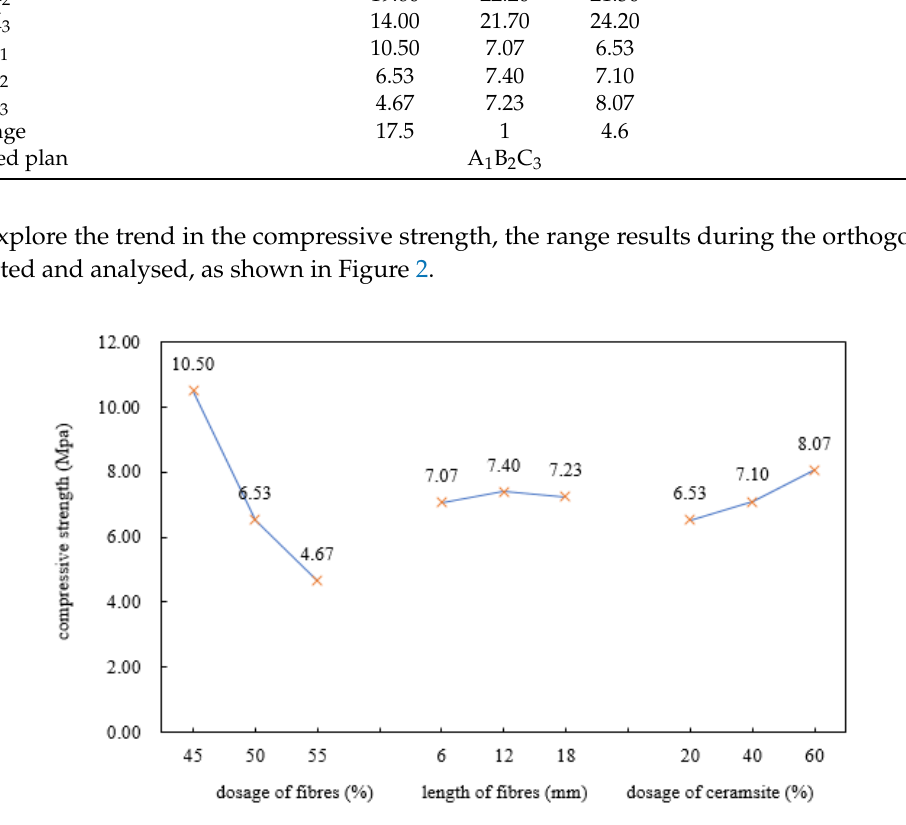
Figure 2. Changes in compressive strength.